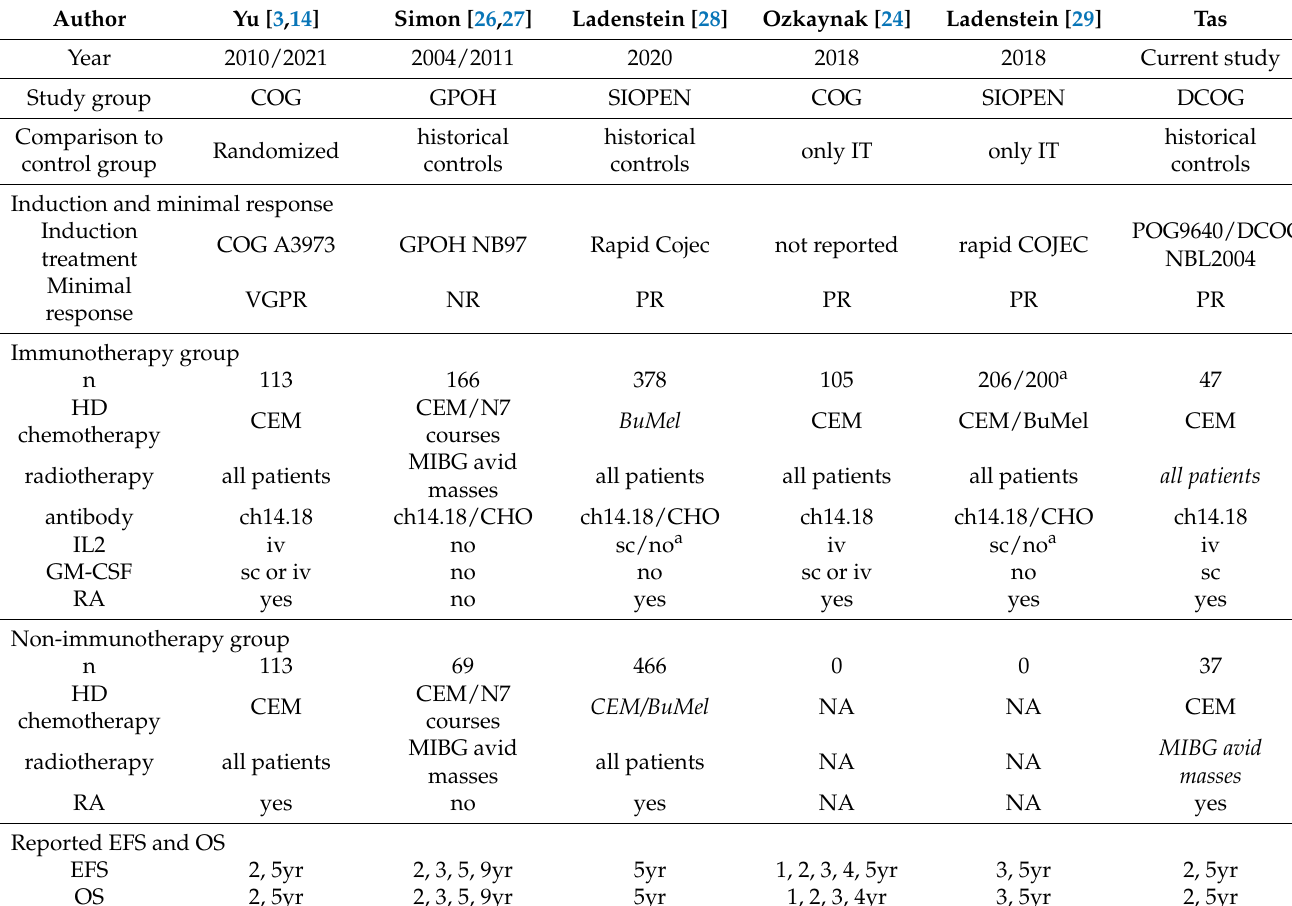
Table 2. Literature cohorts of patients receiving